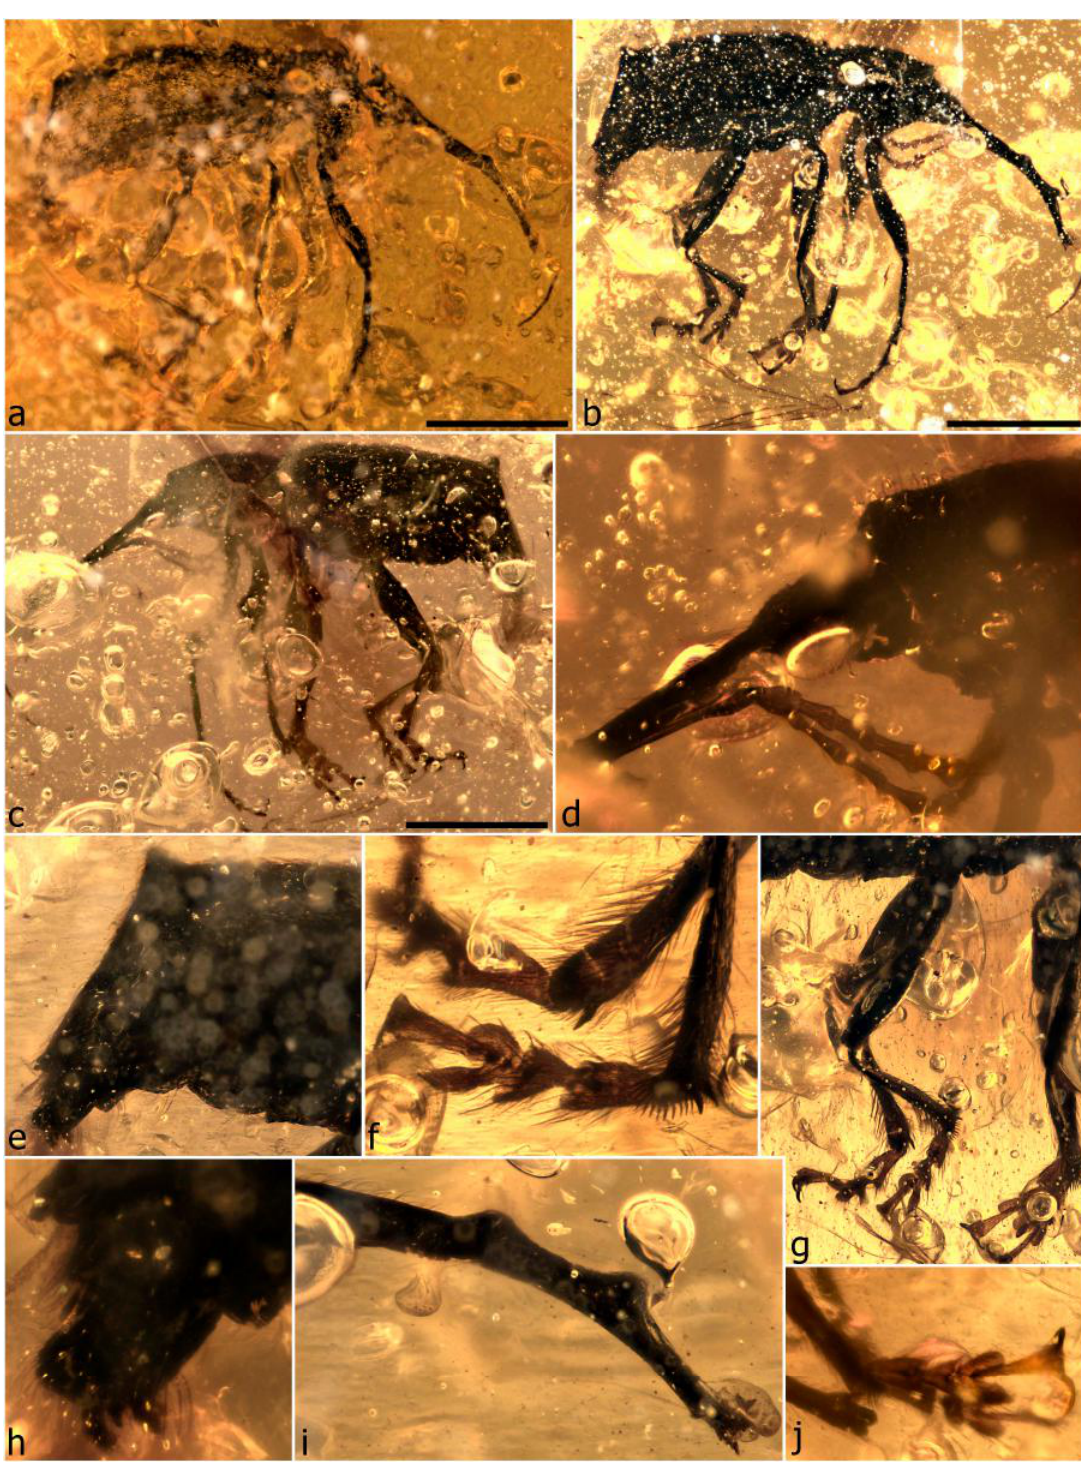
Figure 46. Cyrtocis gibbus sp. n., holotype. Habitus, right lateral ( a ); habitus, right lateral (different lighting) ( b ); habitus, left lateral ( c ); head, prothorax, and antenna, left lateral ( d ); posterior part of abdomen, right lateral ( e ); metatibiae and -tarsi ( f ); hindlegs, right ( g ); apex of abdomen, right lateral ( h ); rostrum, right lateral ( i ); mesotarsus, left ( j ). Scale bars: 1.0 mm (a–c).